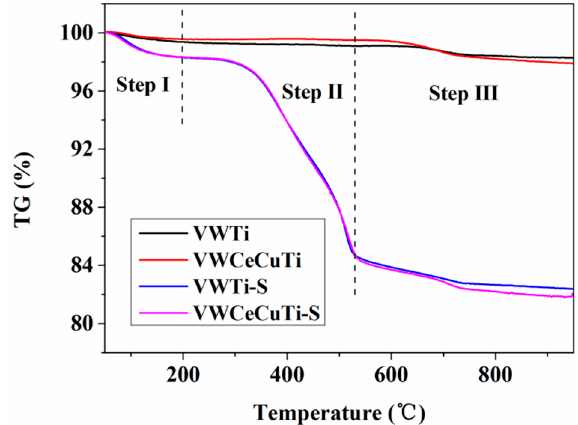
Figure 3. TGA profiles of fresh and S-poisoned catalysts.